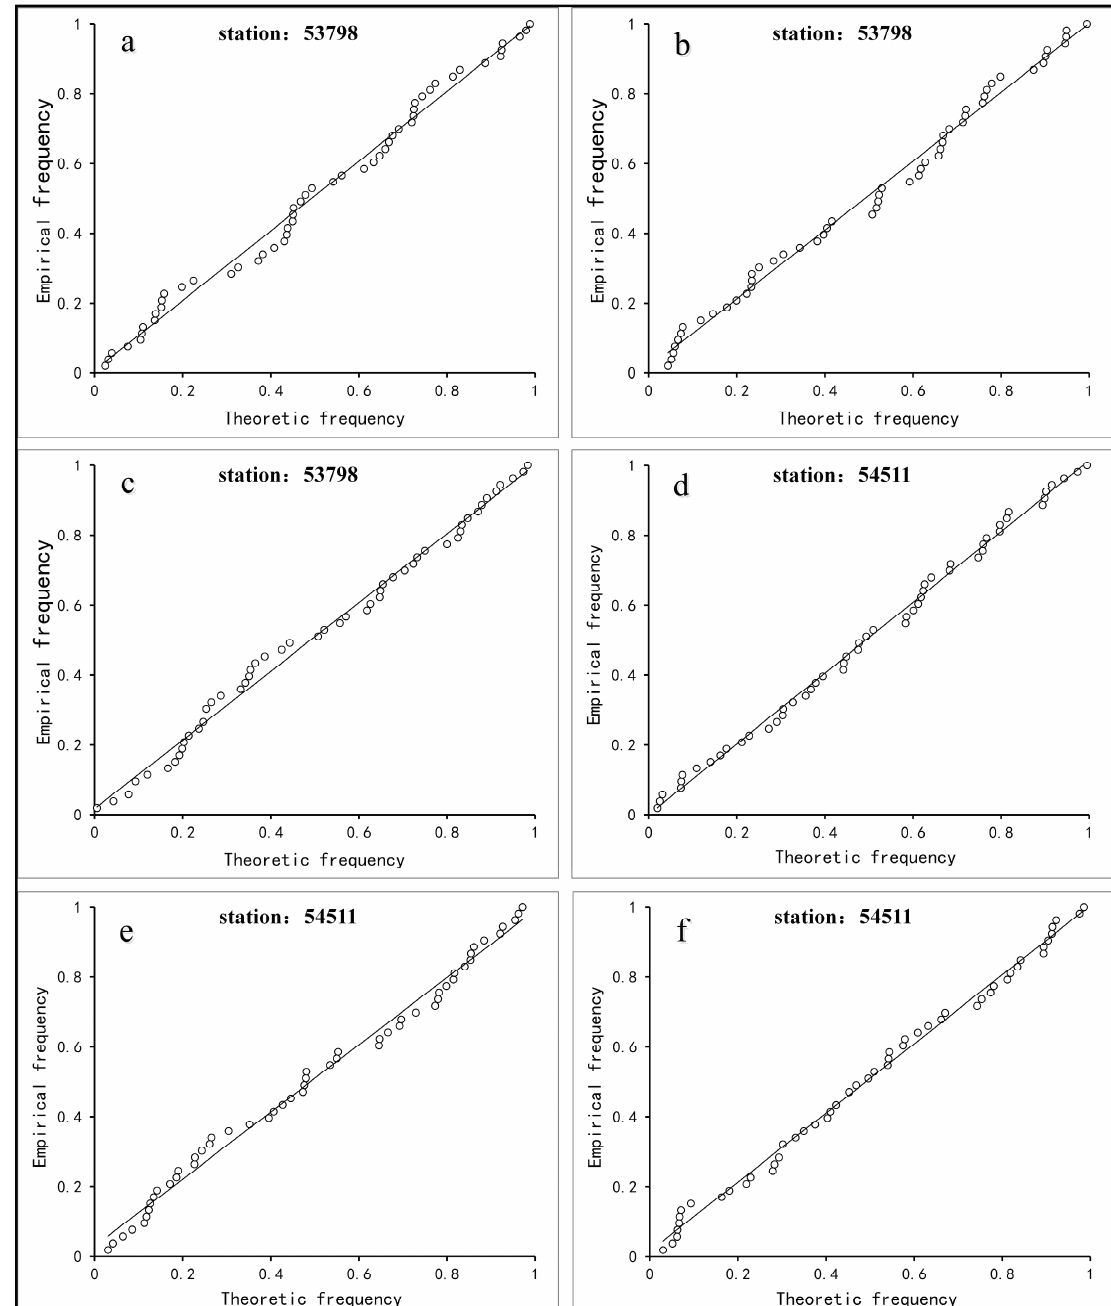
Figure 3. The comparison between empirical frequency and the best-fit distributions’ theoretical frequency of seasonal precipitation at meteorological stations 53798 and 54511 (station 53798: ( a ) for spring; ( b ) for summer and ( c ) for autumn; station 54511: ( d ) for spring; ( e ) for summer; ( f ) for